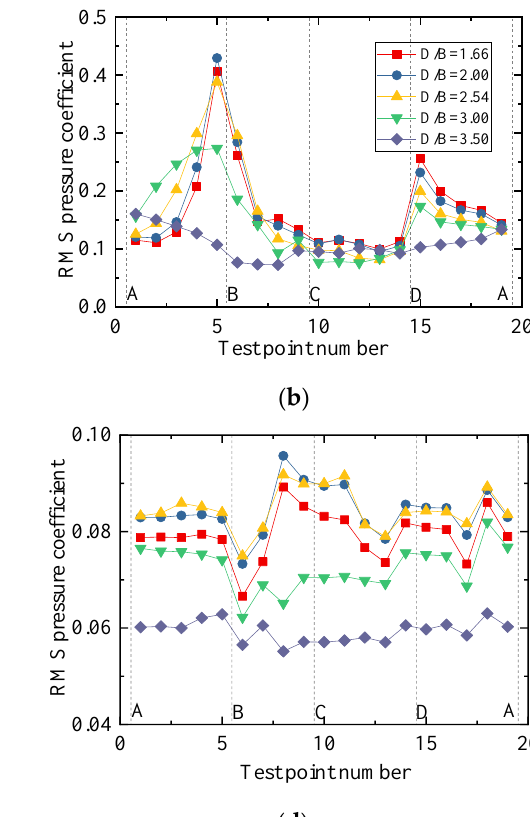
Figure 12. Comparison of the ( a ) aerodynamic coefficients and ( b ) interference factor downstream of the bridge for various D/B ratios in Case 2.